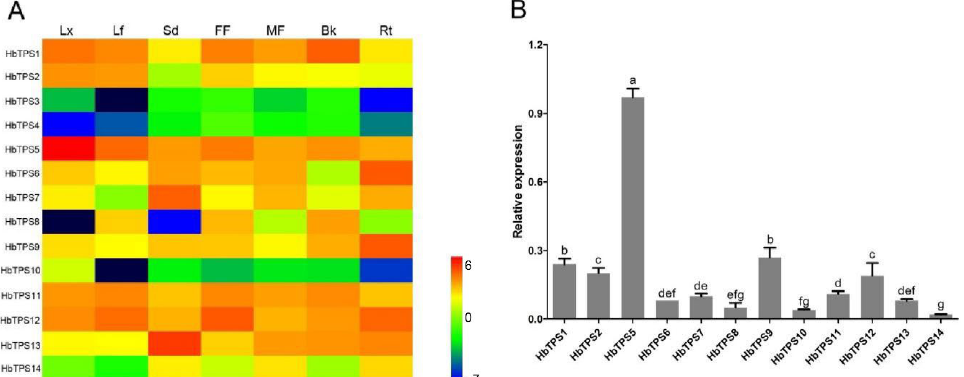
Figure 2. Tissue expression patterns of HbTPS genes. ( A ) Expression of 14 HbTPS genes in seven Hevea tissues, viz. latex (Lt), leaf (Lf), seed (Sd), female flower (FF), male flower (MF), bark (Bk), and root (Rt). The heat map is drawn using the R package based on the Log 2 reads per kilobase exon per million mapped reads (RPKM) of the RNA-Seq data. ( B ) Relative expression of 12 HbTPS genes in Hevea latex by qPCR. Values are means ± standard deviations of three biological replicates. Different letters indicate significant differences across different HbTPS genes (Student’s t -test was performed using Excel 2019, p ≤ 0.05).